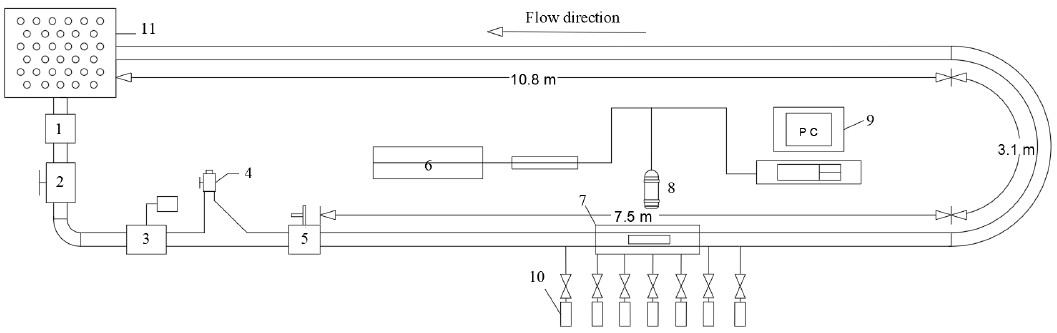
Figure 5. Experimental system. Note: 1. Centrifugal pump. 2. Regulating valve. 3. Electromagnetic flowmeter. 4. Feeding device. 5. Brake device. 6. Laser Doppler velocimeter. 7. Rectangular water jacket. 8. Laser probe. 9. Computer. 10. Pressure sensors. 11. Water